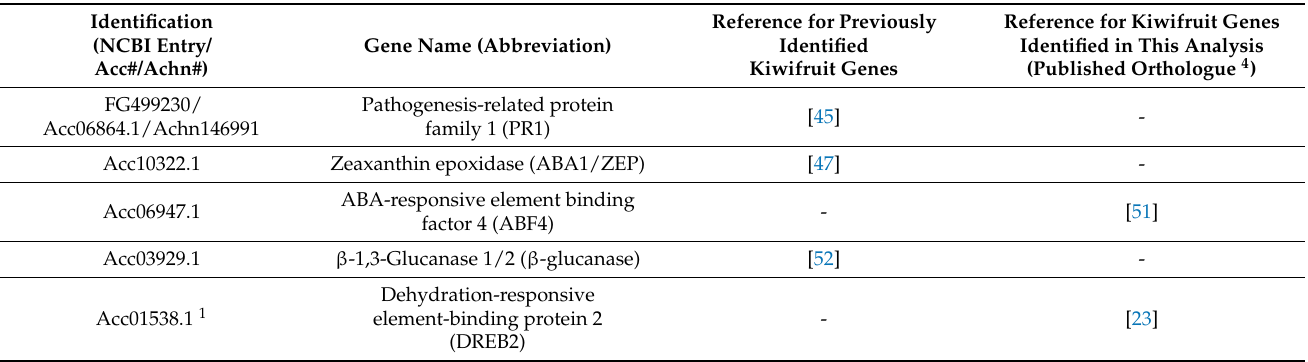
Table 3. Genes of interest for analysis of water stress responsiveness, with measurement by PlexSet ®